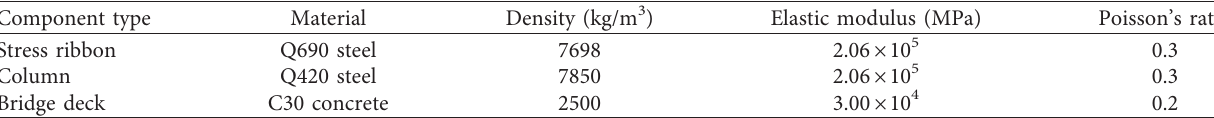
Figure 9: FE model of the bridge. (a) Overall FE model; (b) configuration of column bracket (without a top plate for clarity); (c) configuration of Table 3: Material parameters.